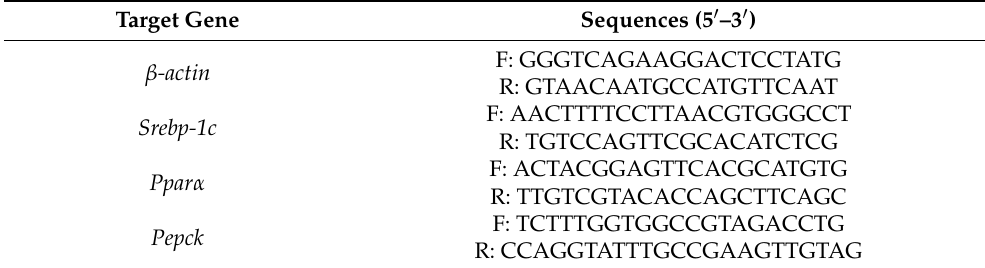
Table 1. Quantitative RT-PCR primer design. Target